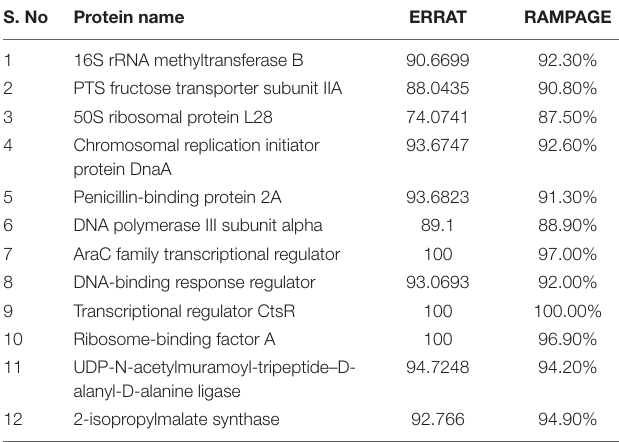
TABLE 4 | Validation score of models from RAMPAGE and ERRAT.